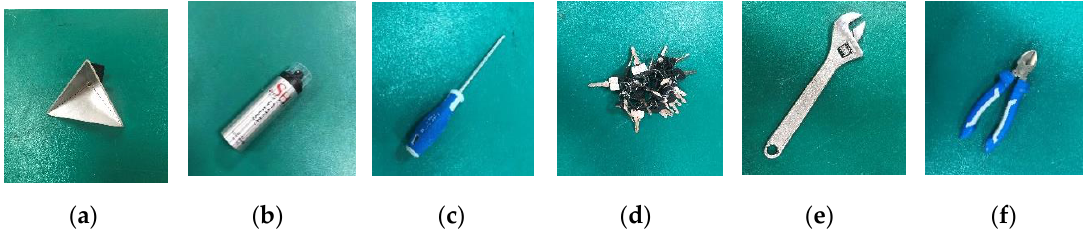
Figure 7. The calibration object and foreign object debris (FOD)targets: ( a ) Calibration object: a trihedral